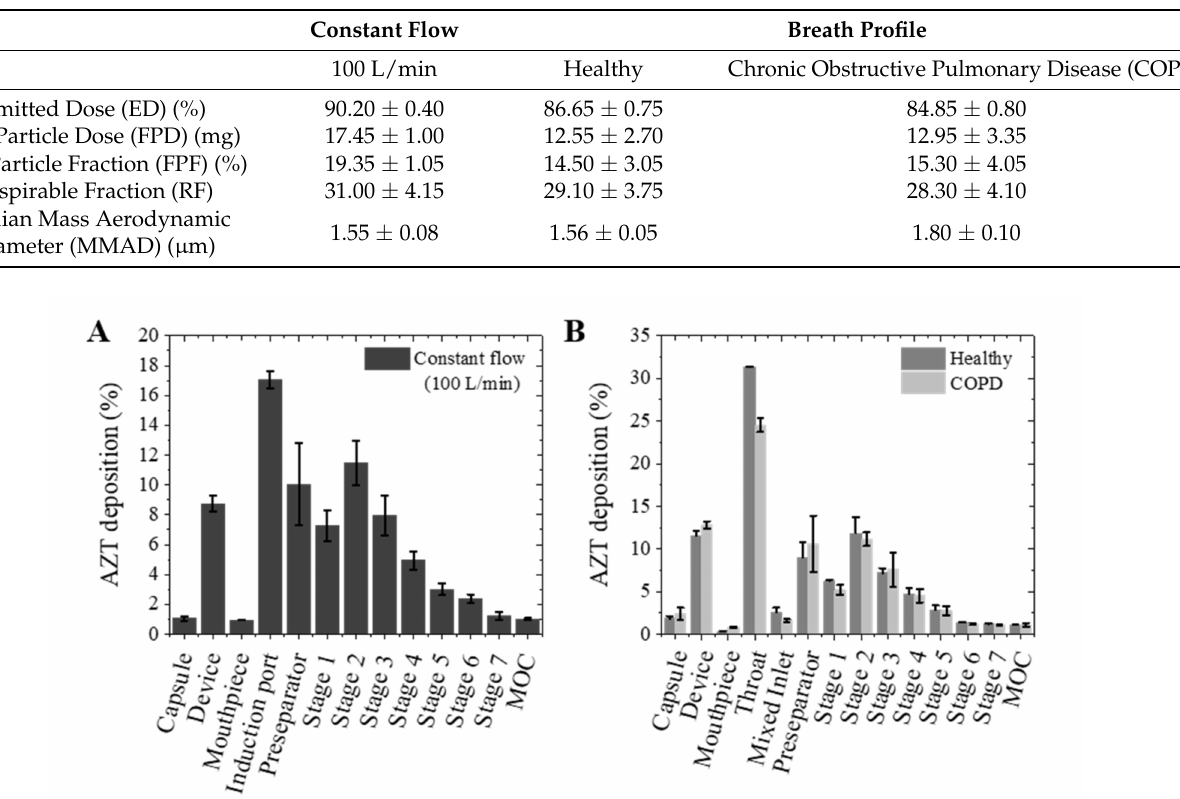
Figure 5. Aerodynamic particle size distribution: ( A ) mass deposited in the next generation impactor at constant flow (100 L/min); ( B ) mass deposited in the next generation impactor with respiratory profile from healthy and COPD patient (mean ± SD, n =